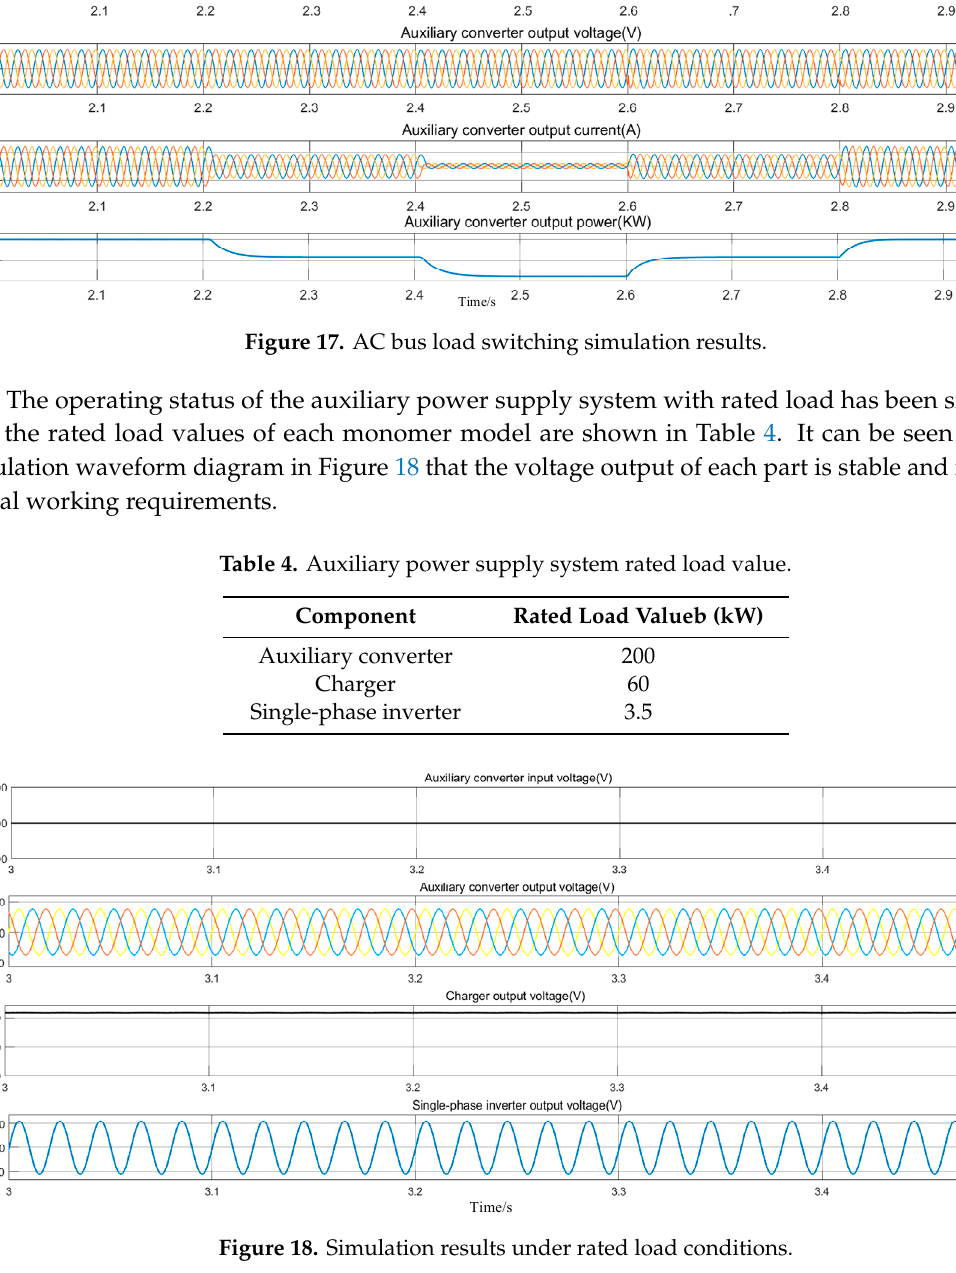
Figure 18. Simulation results under rated load conditions.